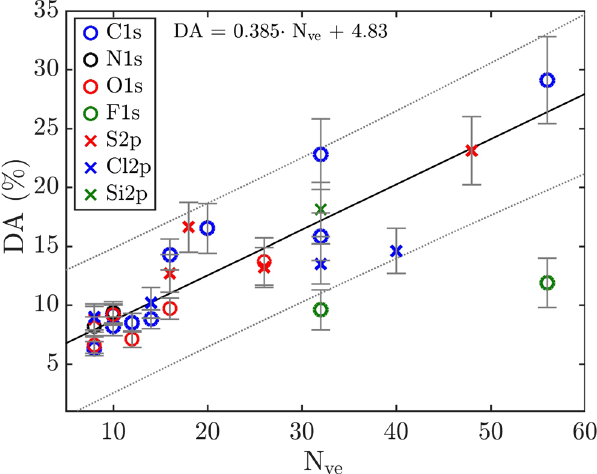
Figure 1. Percentage of double Auger as a function of the number of available valence electrons. A robust regression (solid line) show the trend among the molecules in Table 1, with a 95% confidence interval (dotted line) for the fit. The standard error in each data point is displayed as an error bar.